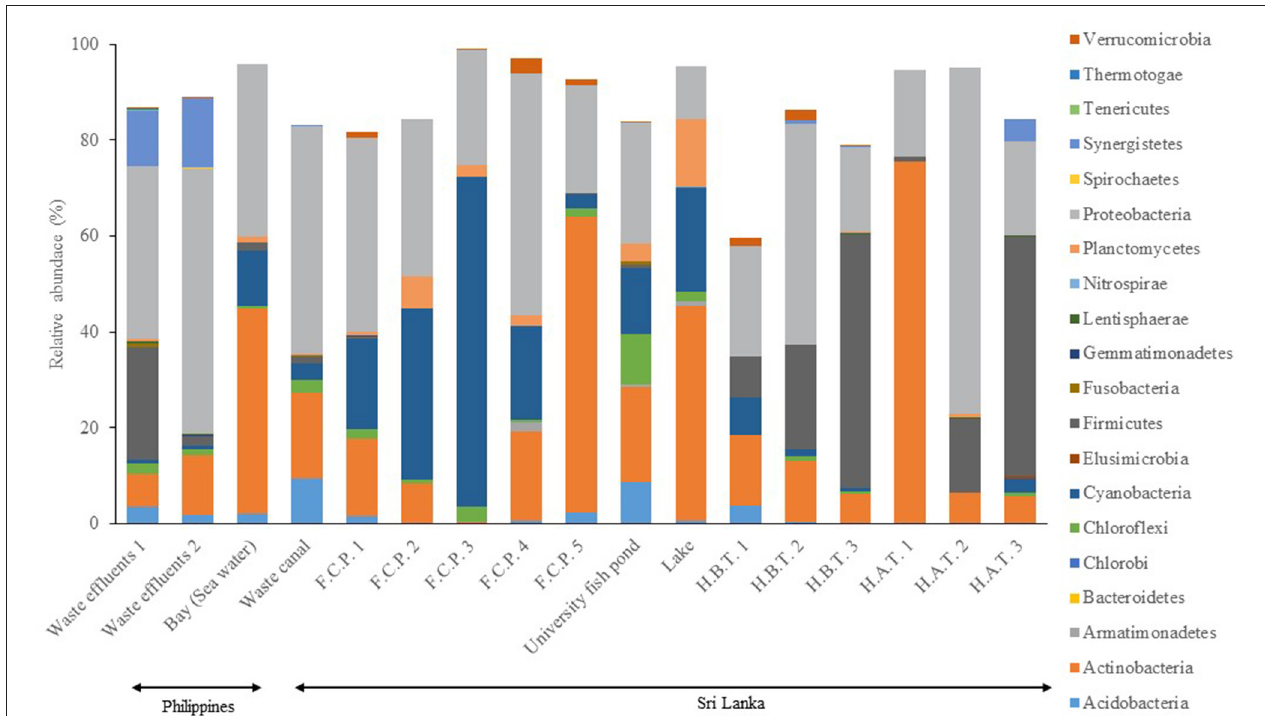
FIGURE 1 | Distribution (relative abundance) of bacterial phylum in water samples. FCP, Commercial Fish Culture Pond; HAT, Hospital Wastewater (After Treatment); HBT, Hospital Wastewater (Before Treatment). The information of sample type is available in Table 1